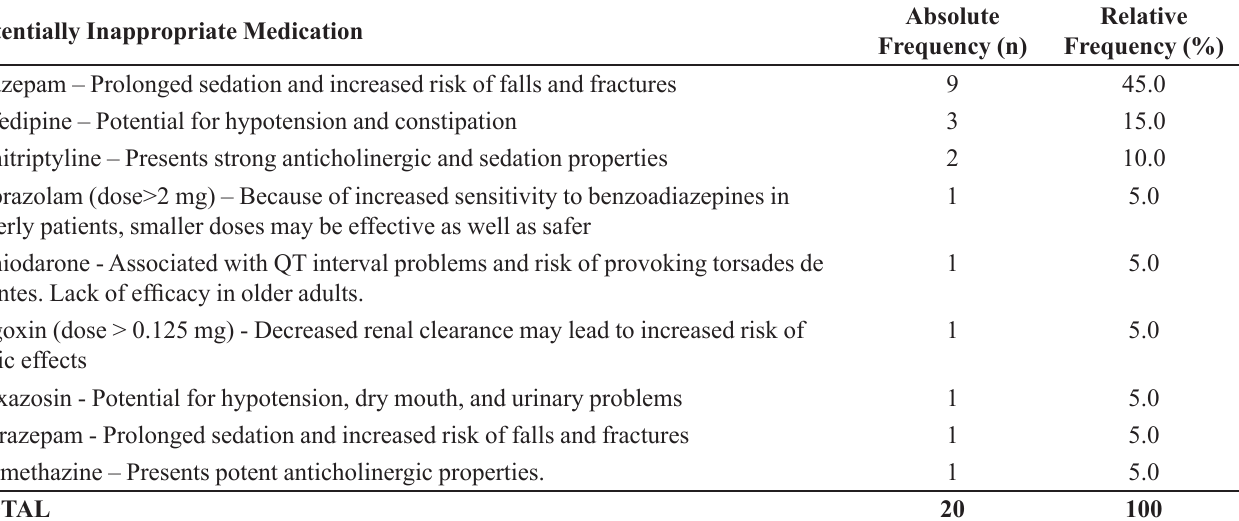
TABLE I - Frequency of potentially inappropriate medication prescription according to the Beers’ criteria Potentially Inappropriate